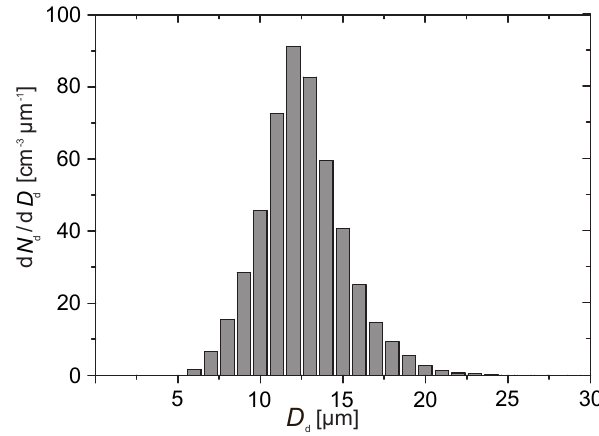
Fig. 5. Average droplet number size distribution corresponding to time period displayed in Fig.